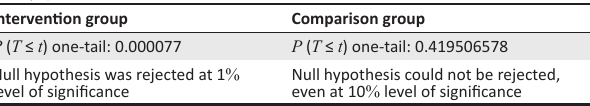
TABLE 3: Intervention sessions. Session Activities Number